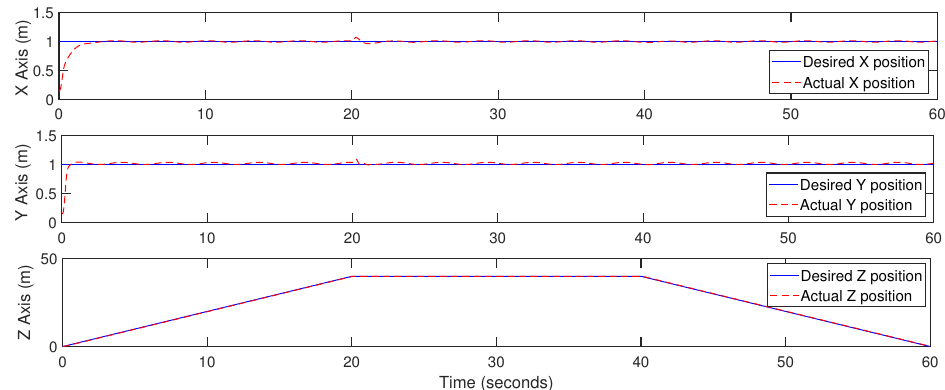
Figure 11. Position tracking when disturbance [1 + sin ( 2 t ) 1 + sin ( 2 t ) 1 + sin ( 2 t ) ] applied.